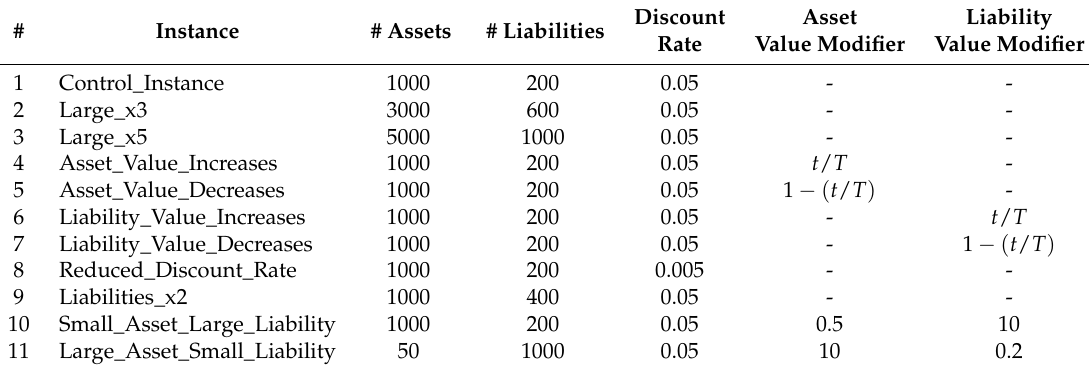
Table 1. Characteristics of the set of